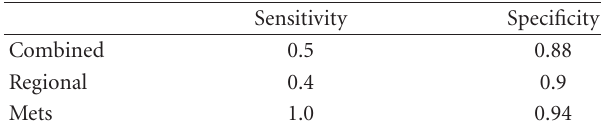
Table 3: Sensitivity and specificity.